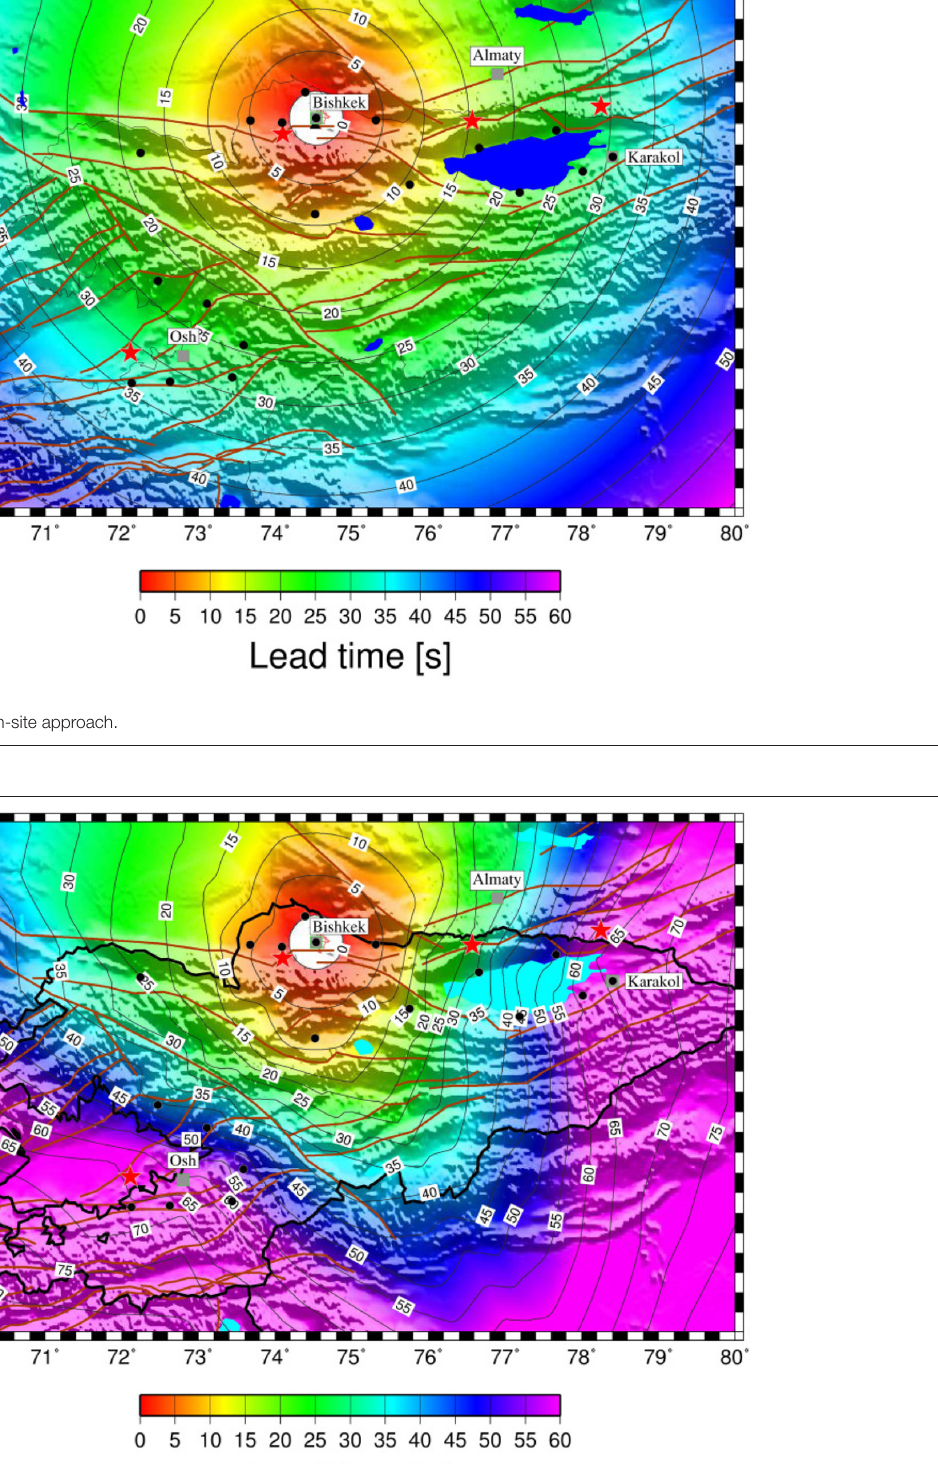
Frontiers in Earth Science |